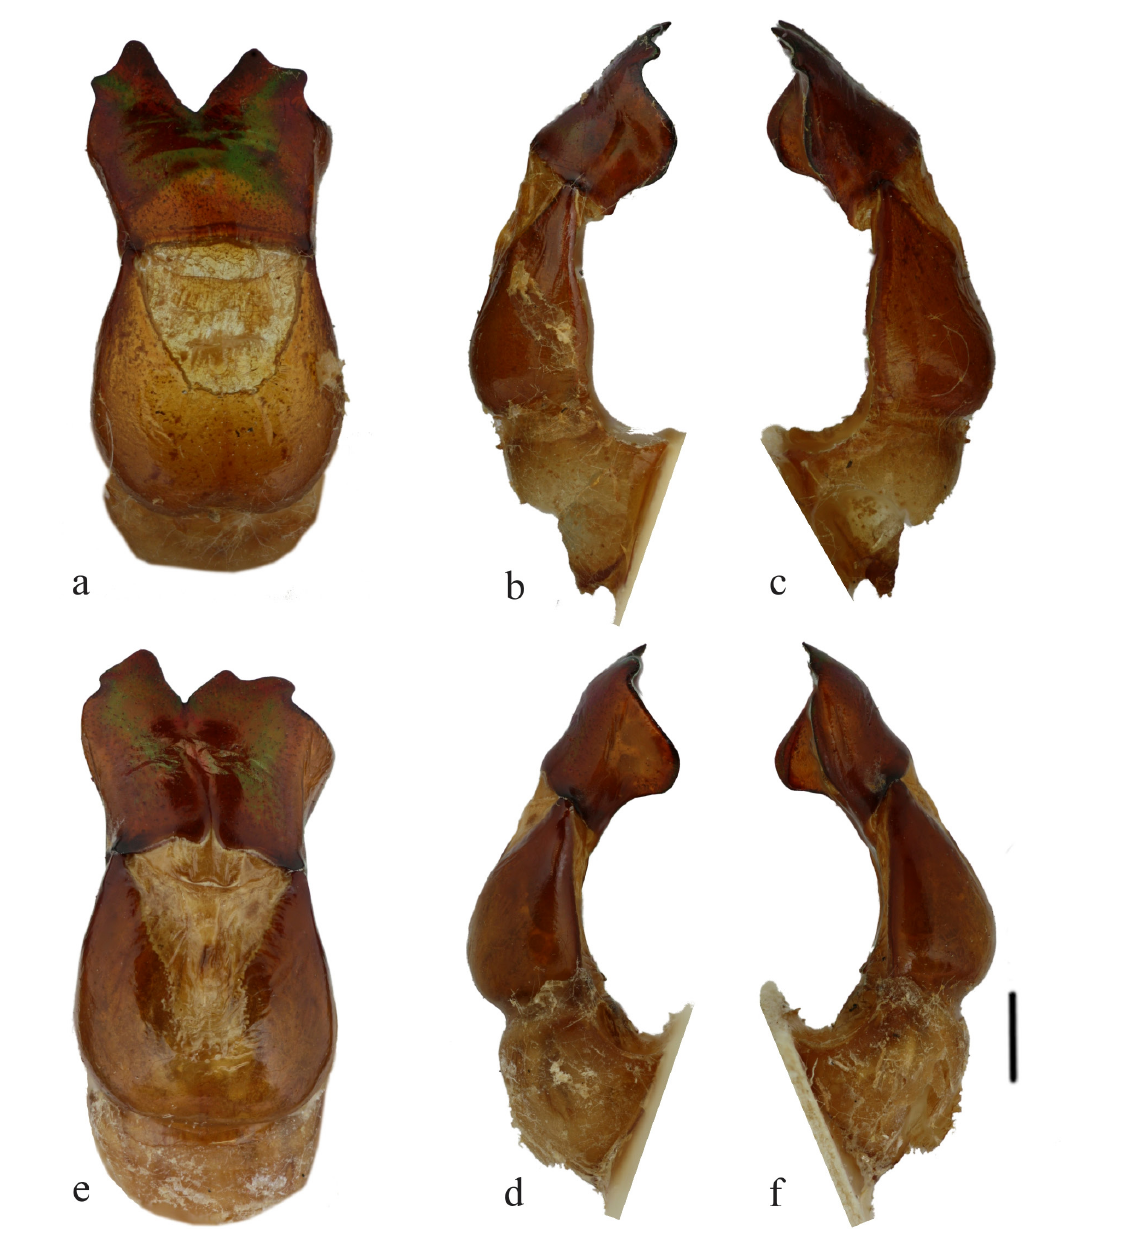
Fig. 5. Aedeagus in dorsal (a, e) y lateral view (b–c, d, f). a–c . Oplognathus kirbii MacLeay, 1819 (ZMHB). d–f. Oplognathus bahianus Ohaus, 1912, syntype, ♂ (ZMHB). Scale bar = 1